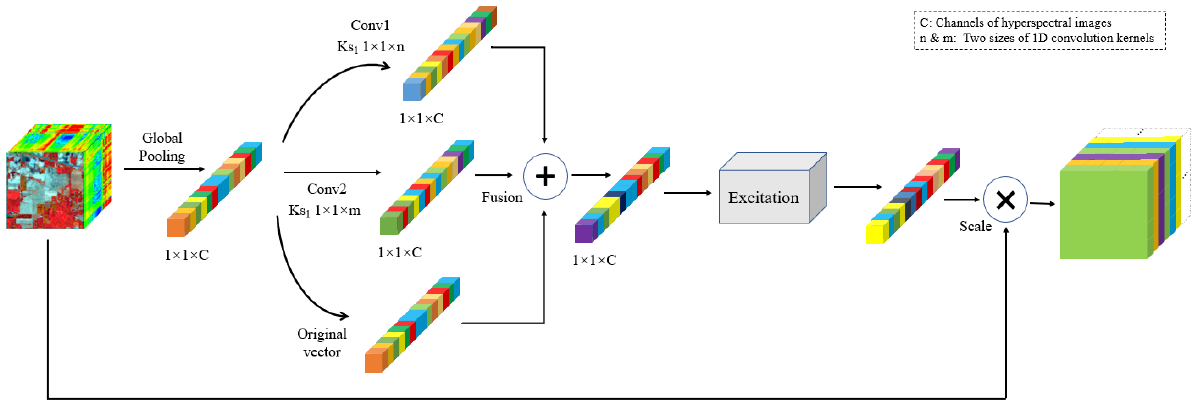
Figure 1. The structure of the FsSE module. After global average pooling, two different scales of convolution are fused to obtain the correlation characteristics between different spectra, and then the model can learn the fused features better by the excitation module (i.e., a fully connected layer with the same number of nodes in both layers). Finally, the spectral channels of hyperspectral images are weighted by scale operation.